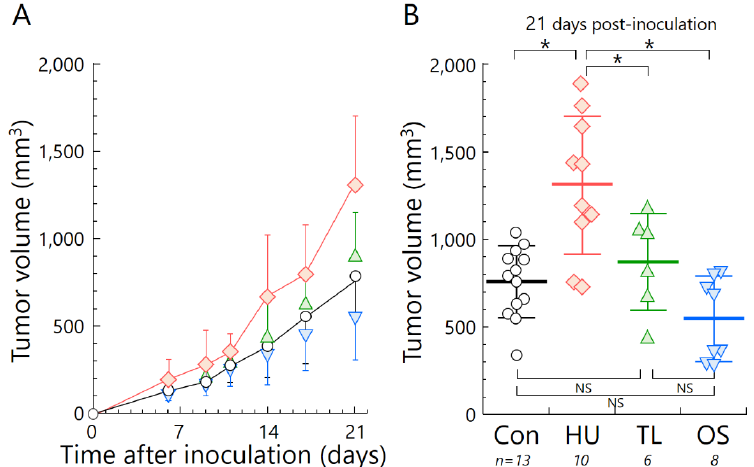
Figure 2. Tumor growth of mice in the four suspension conditions. ( A ) Tumor volume after tumor cell inoculation and ( B ) at day 21 post-inoculation. Circles, standard housing control group (Con); diamonds, hind-limb unloading (HU); triangles, temporary loading during HU (2 h per day) (TL); inverted triangles, orthostatic suspension (OS). Error bars indicate standard errors. * p < 0.05; NS, not significant (using ANOVA test).